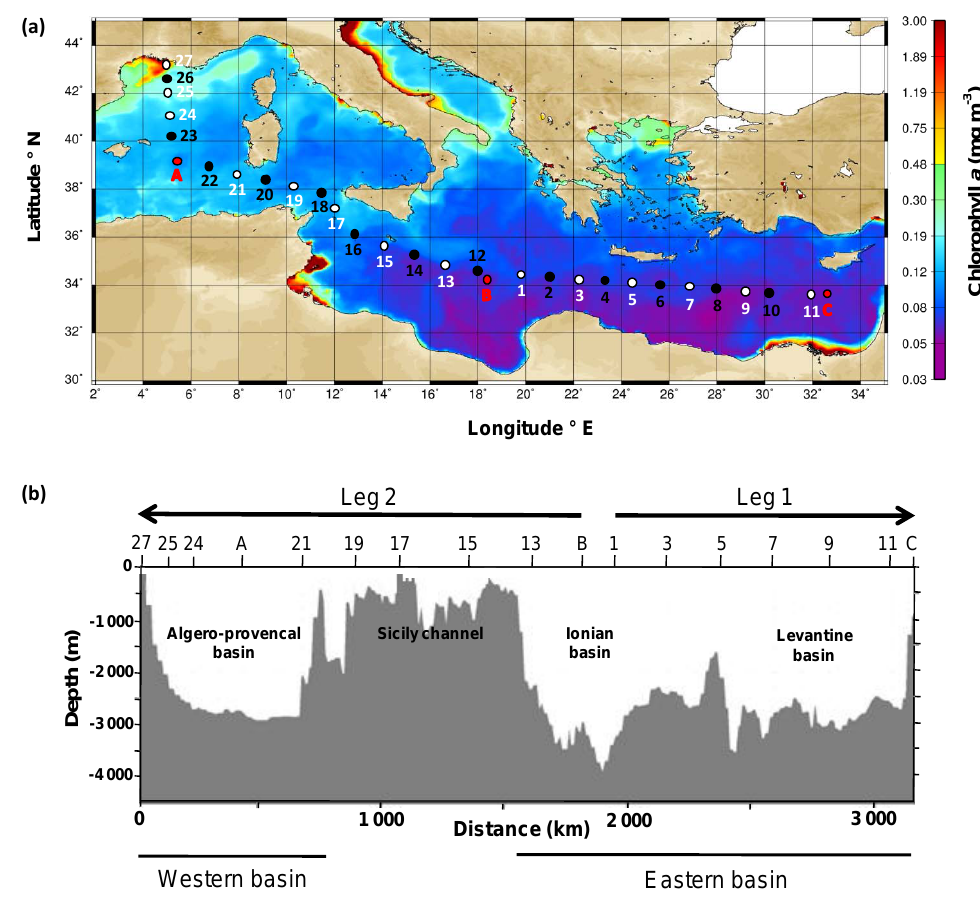
Fig. 1. (a) Location of sampling stations superimposed on a SeaWIFS composite image of the sea surface integrated chlorophyll- a con- centration (permission to E.Bosc) during the BOUM transect (16 June–20 July 2008). Short-stay stations where zooplankton was sampled (white) and not sampled (black) and long-stay stations (red). (b) Bottom depth and geographic areas along the transect.